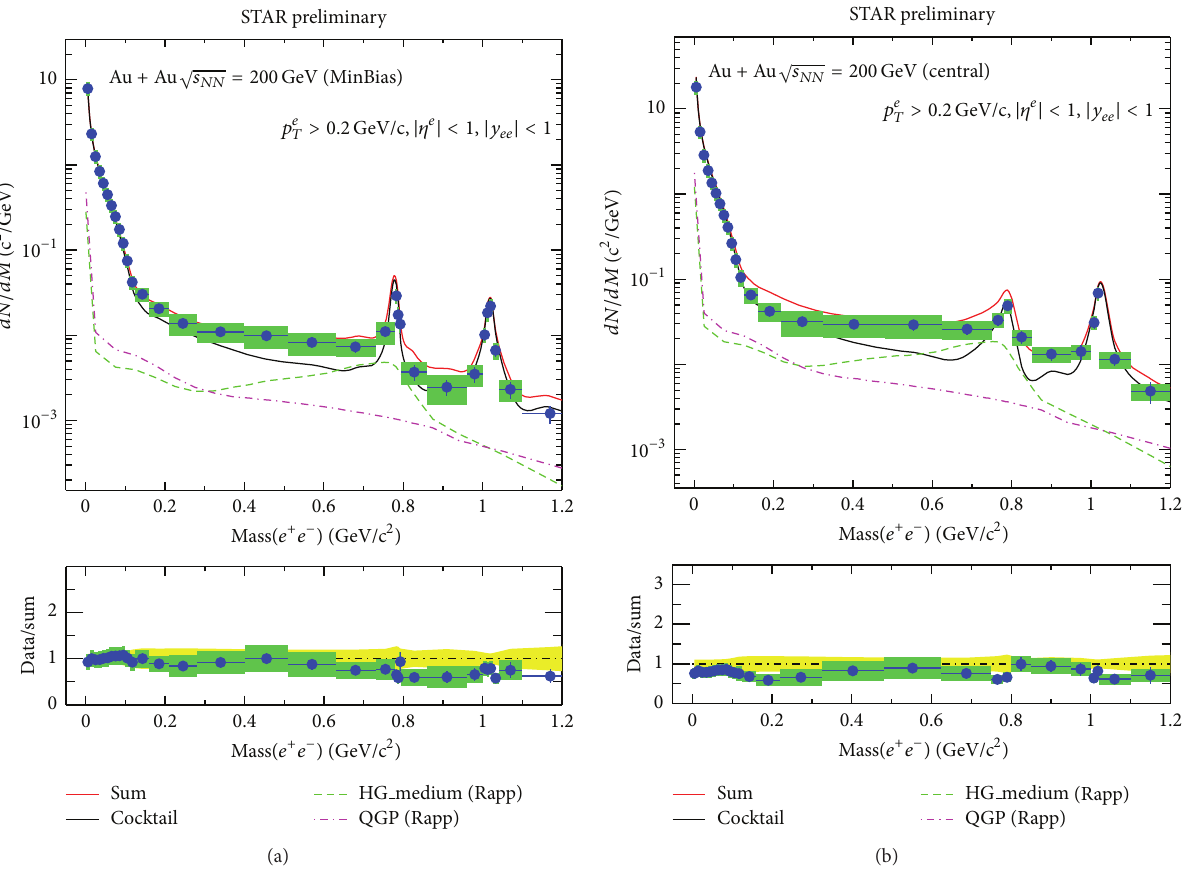
Figure 5: Dilepton invariant-mass spectra in Au-Au(200 AGeV) for minimum-bias (a) and central (b) collisions. Theoretical calculations for thermal radiation from a nonperturbative QGP and in-medium hadronic spectral functions are compared to STAR data [49, 50].